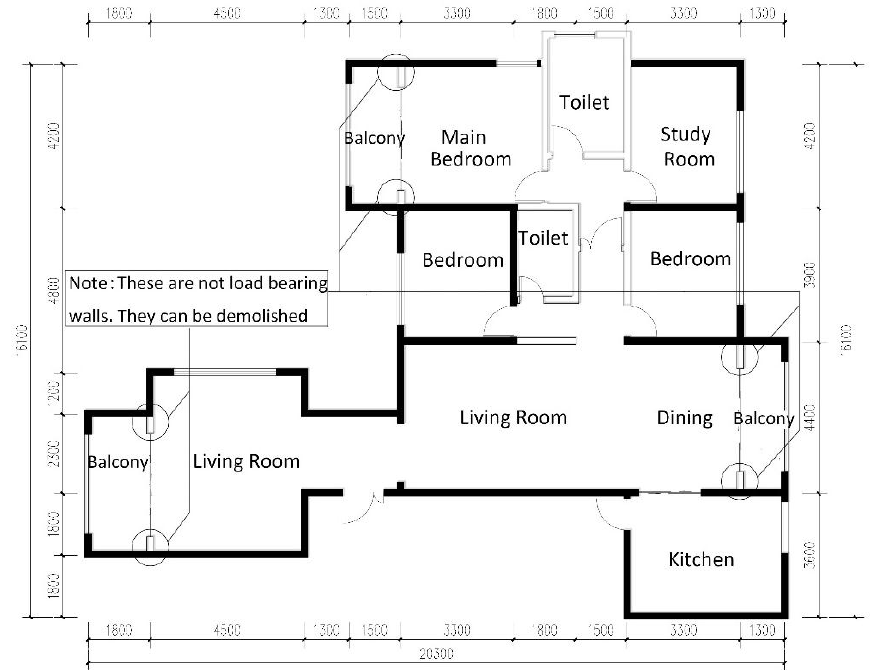
Figure 9. Walls between balconies and the living room, bedroom and dining room redefined as non-load-bearing